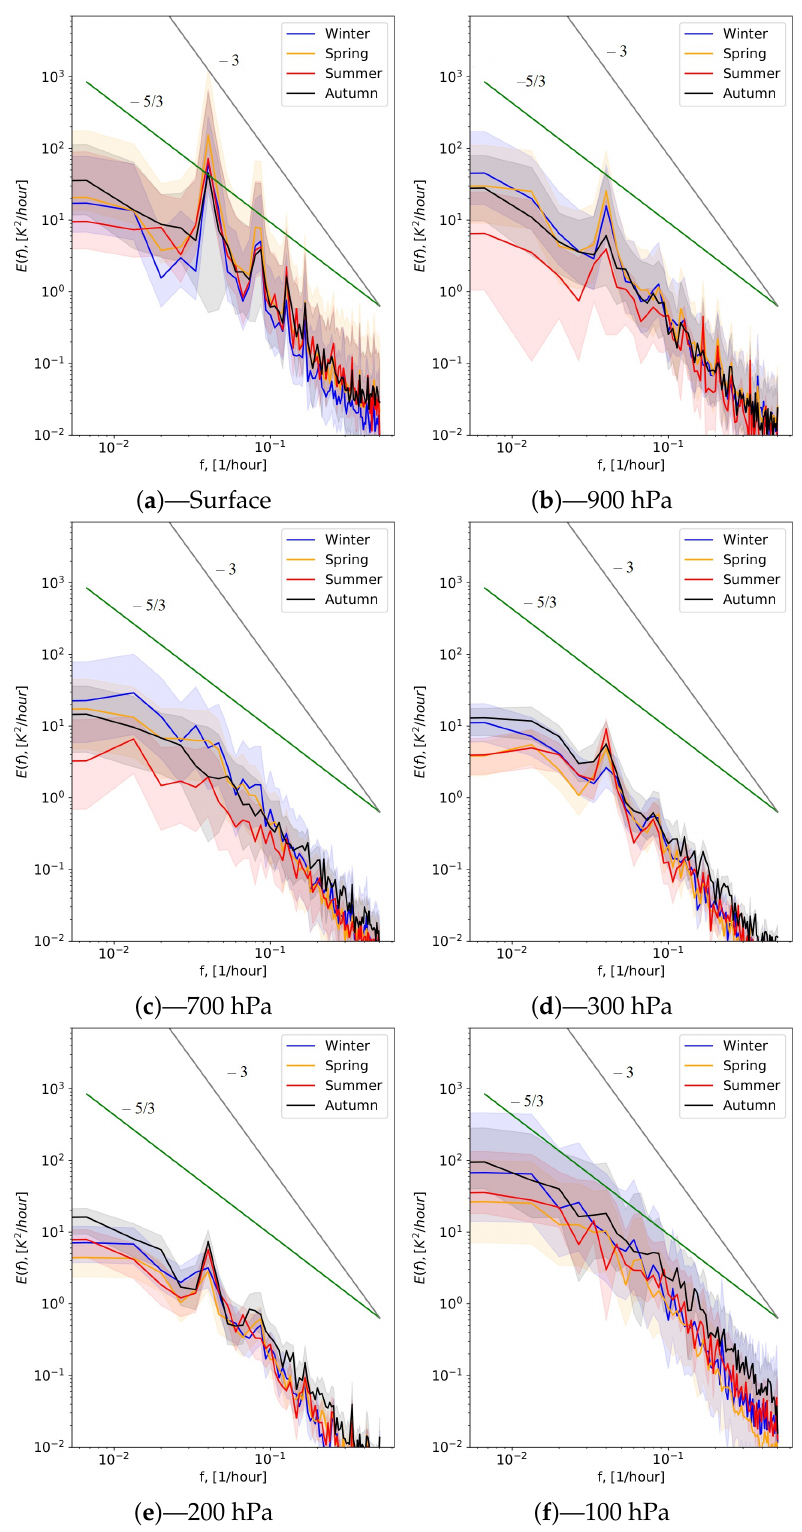
Figure 5. Frequency dependencies of power spectral density of air temperature fluctuations at the Nha Trang observatory